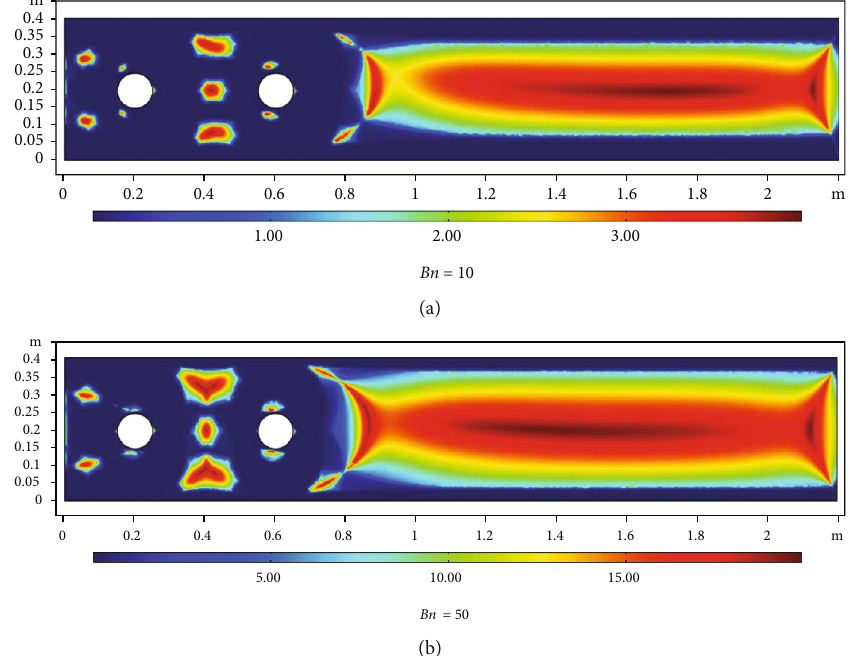
= 0 : 3 and Re = 20 . (a) Bn = 10 . (b) Bn = 50 . p